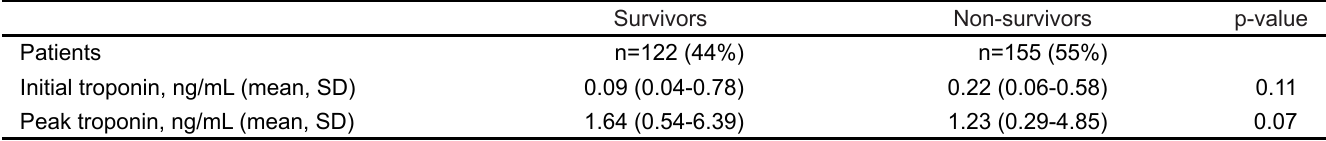
Table 4. Association of initial and peak troponin with survival.